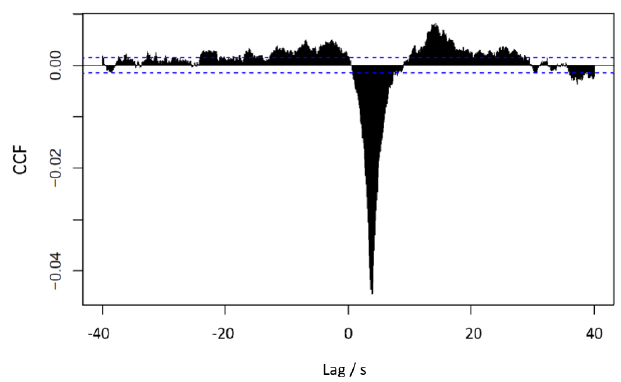
Figure 3. Example cross correlation function (CCF) for ozone and vertical wind on 10 April. The negative peak minimum indicates that ozone data lag 3.9s behind the wind data. Dashed blue lines denote the 95% significance